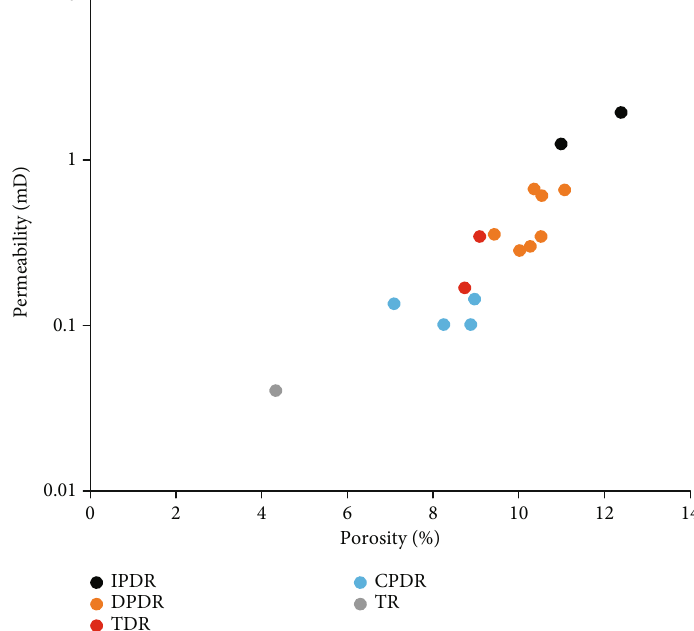
Figure 10: Porosity versus permeability of di ff erent types of reservoirs. IPDR: interparticle pore-dominated reservoir; DPDR: dissolution pore-dominated reservoir; TDR: throat-dominated reservoir; CPDR: clay-related pore dominated reservoir; TR: tight